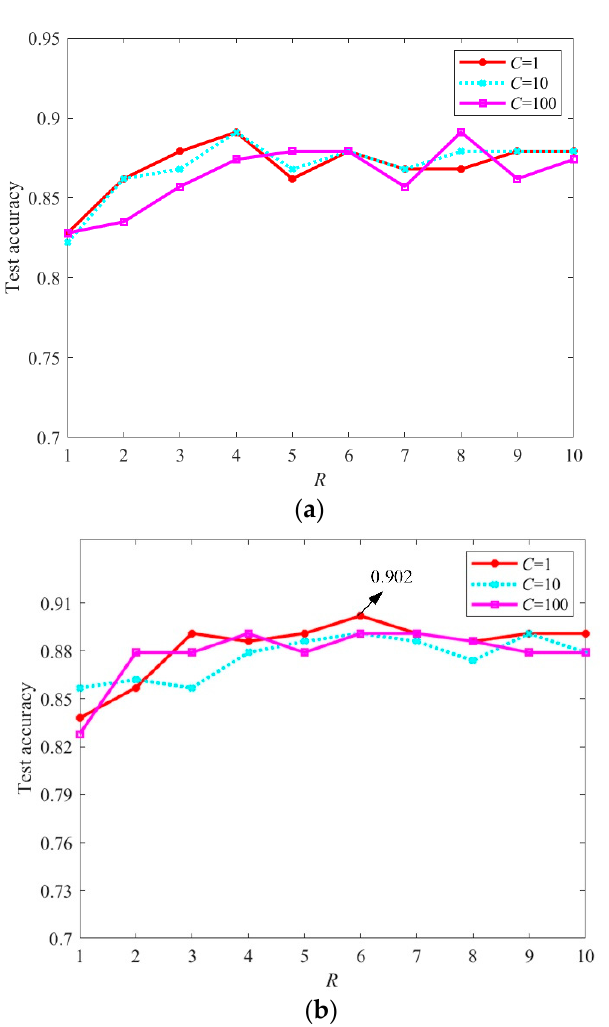
Figure 8. The classification accuracies of MCMS-STM under different R and C using dataset 1. ( a ) The classification accuracies of OVR version of MCMS-STM with different R and C ; ( b ) The classification accuracies of OVO version of MCMS-STM with different R and C .